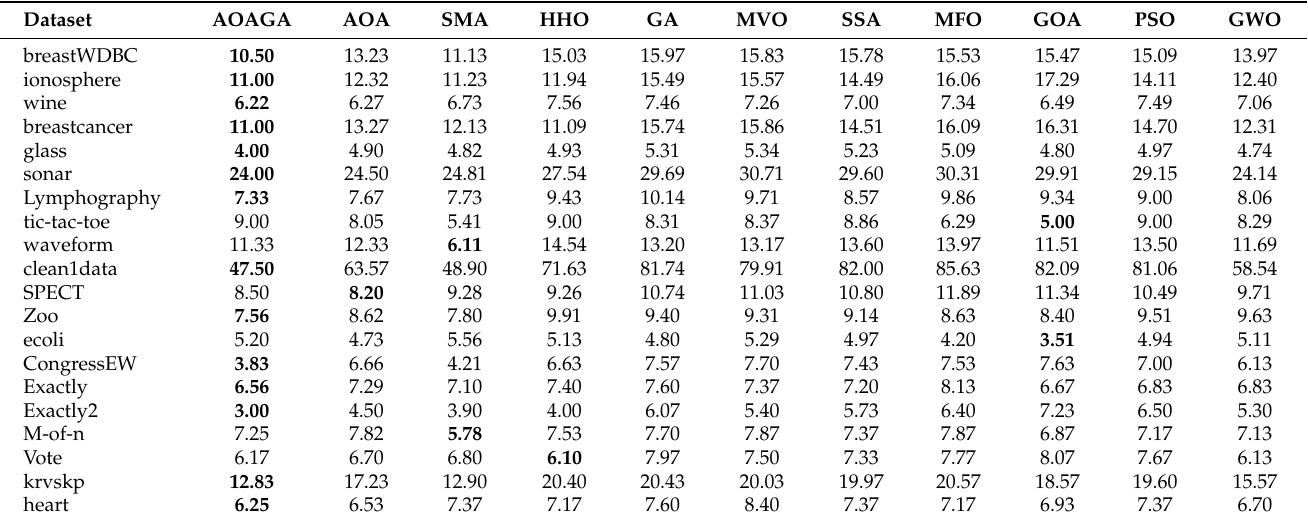
Table 7. Selected features number obtained by each